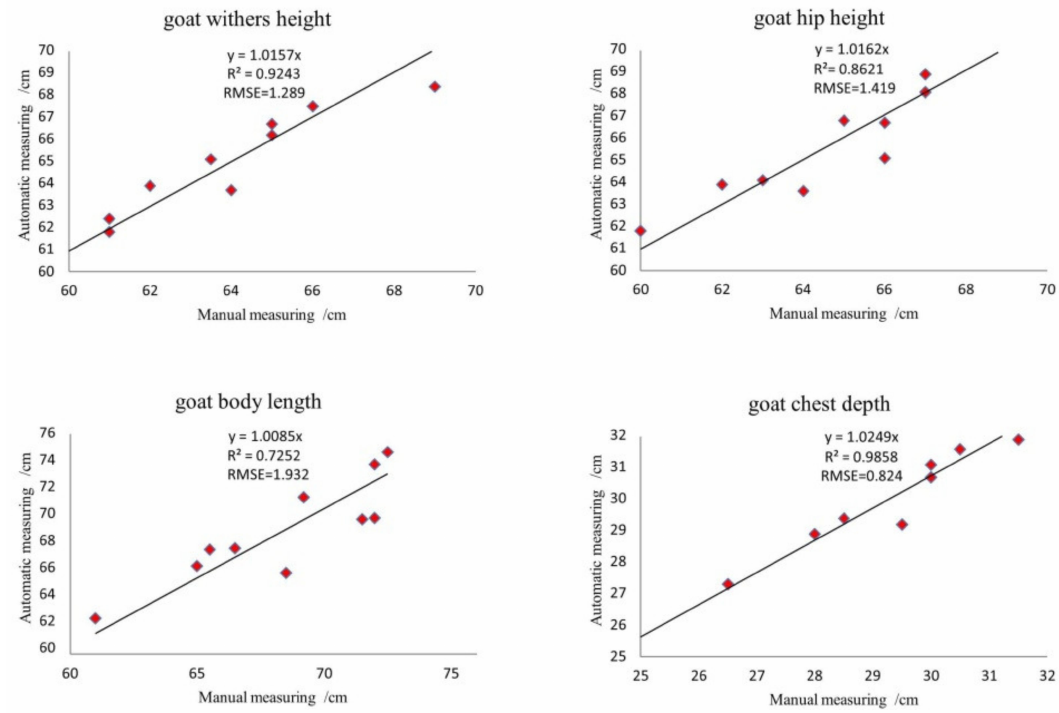
Figure 20. Linear Regression Analysis of goat body